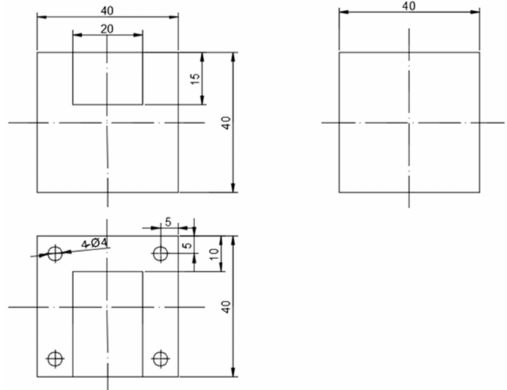
Figure 3. Workpiece dimensions.